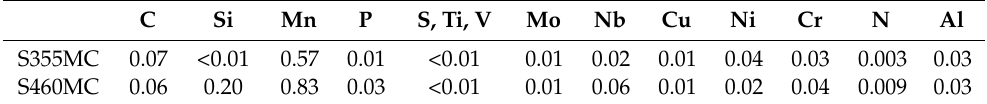
Table 1. Chemical composition (wt.%) of S355MC and S460MC steels.